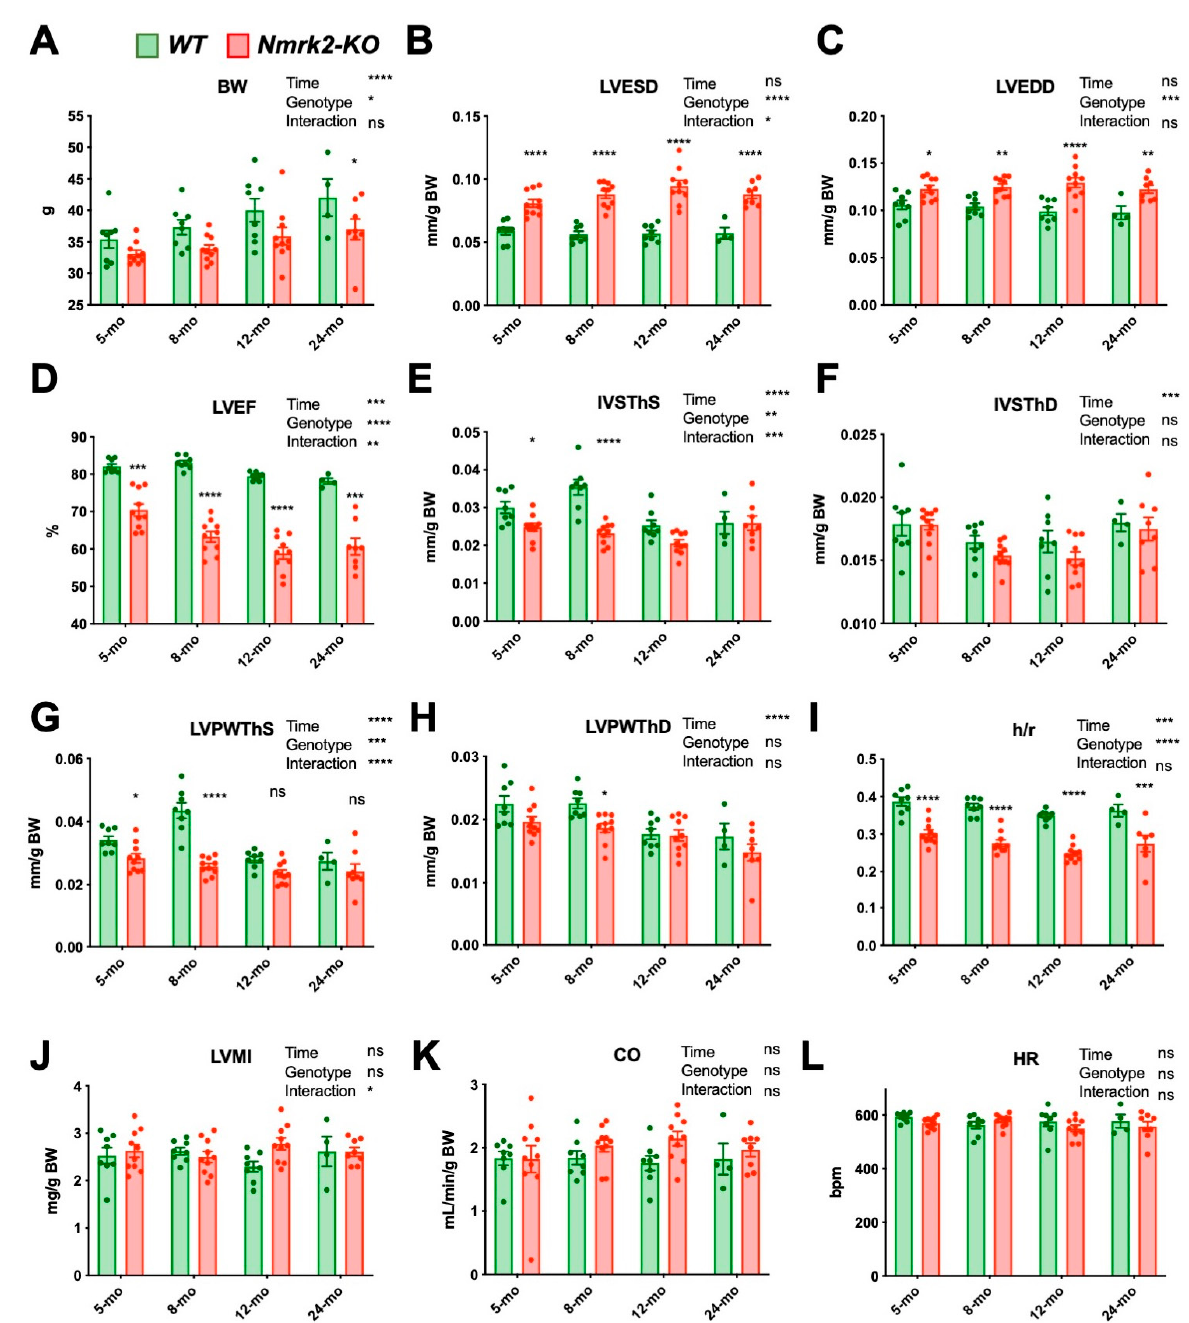
Figure 4. Cardiac dysfunction and left ventricle dilatation take place with aging in the Nmrk2-KO mice. Follow-up echocardiography analysis of Wt ( n = 8) and Nmrk2-KO mice ( n = 10) at 5, 8, 12 and 24 months (mo). ( A ) Body weight. ( B ) LV end-systolic and ( C ) end-diastolic diameter. ( D ) LV ejection fraction. ( E ) End-systolic and ( F ) end-diastolic interventricular septum thickness. ( G ) End-systolic and ( H ) end-diastolic LV posterior wall thickness. ( I ) LV wall thickness to radius ratio (end diastole). ( J ) LV mass index. ( K ) Cardiac output. ( L ) HR, heart rate in beats per minute. Bars and error bars represent the mean value ± SEM Statistics: Mixed model analysis by restricted maximum likelihood (REML). Fixed factors p value are indicated next to the graph title: *, p ≤ 0.05; **, p ≤ 0.01; ***, p ≤ 0.001; ****, p ≤ 0.0001 for, time, genotype, time x genotype interaction. Sidak’s multiple comparisons test p -value: *, p ≤ 0.05; **, p ≤ 0.01; ***, p ≤ 0.001; ****, p ≤ 0.0001, between control and Nmrk2-KO mice within each age group.